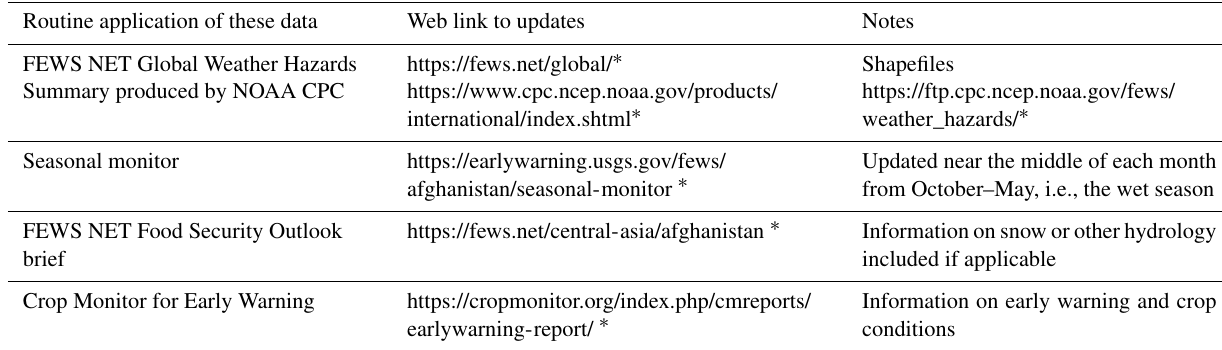
Table 4. Routine applications of FLDAS Afghanistan hydrologic data.